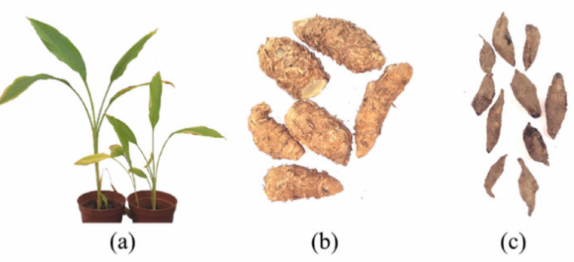
Figure 1. ( a ) The plant of Curcuma wenyujin ; ( b ) Curcuma zedoaria , the dried rhizome of Curcuma wenyujin ; ( c ) Curcumae radix, the dried tuberous root of Curcuma wenyujin